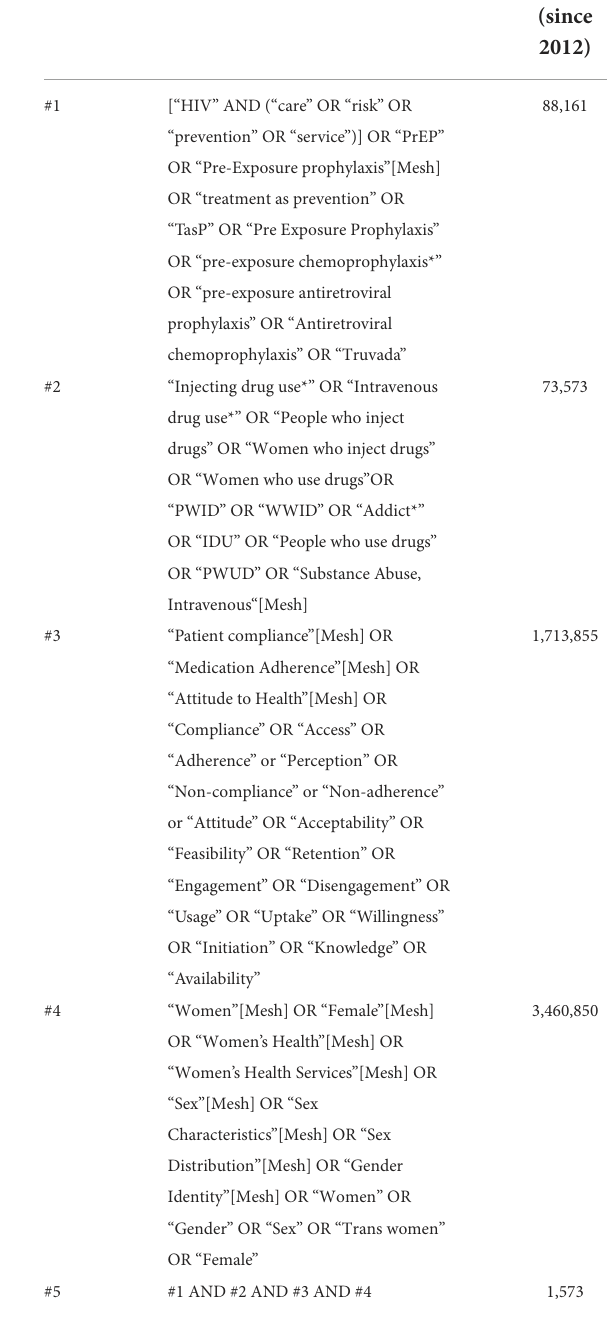
Harm Reduction Network, and the New York Academy of Medicine’s Gray Literature Database.